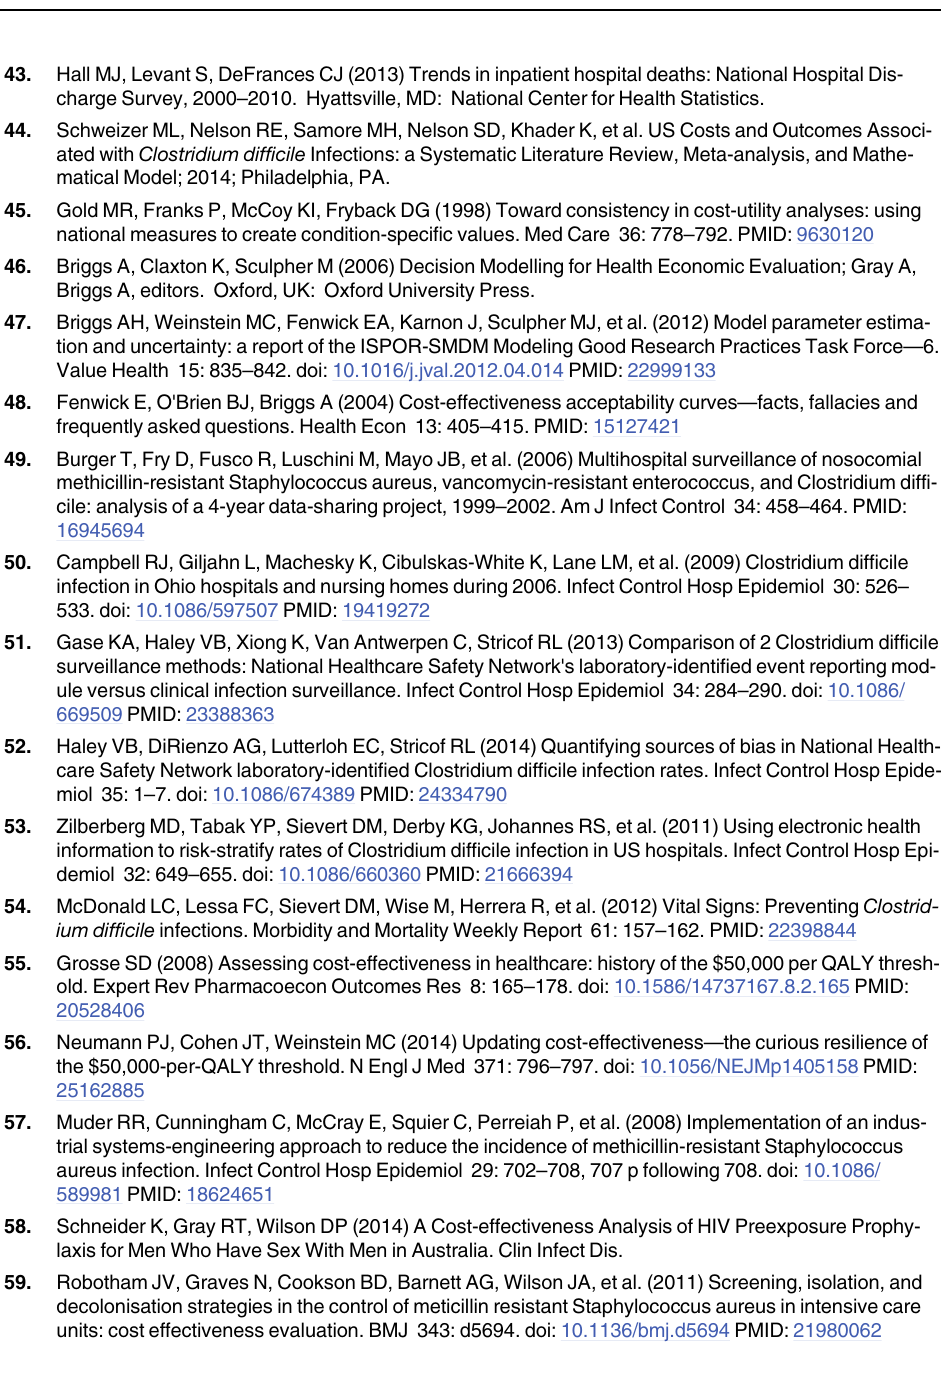
PLOS ONE | DOI:10.1371/journal.pone.0152248 March 31,